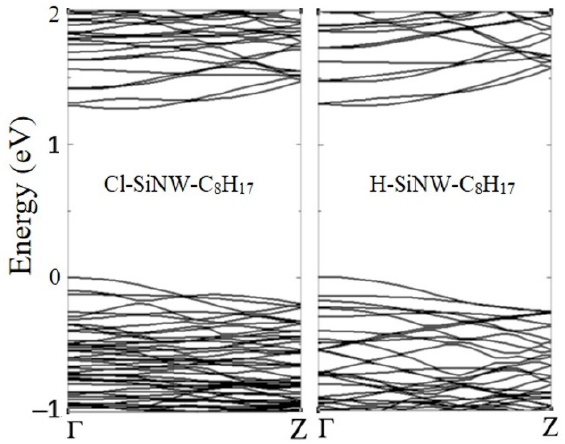
Figure 8. Band structure of Cl- ( left ) and H-SiNWS-C 8 H 17 ( right ) systems. The top of the valence band is set to zero.